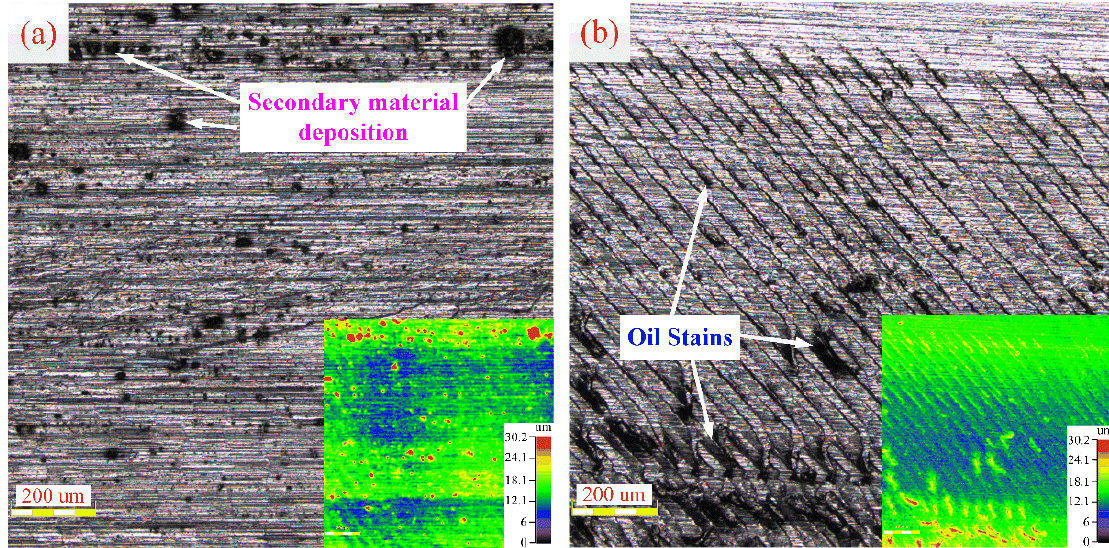
Figure 8. Surface defect: ( a ) secondary material deposition; ( b ) oil stains.